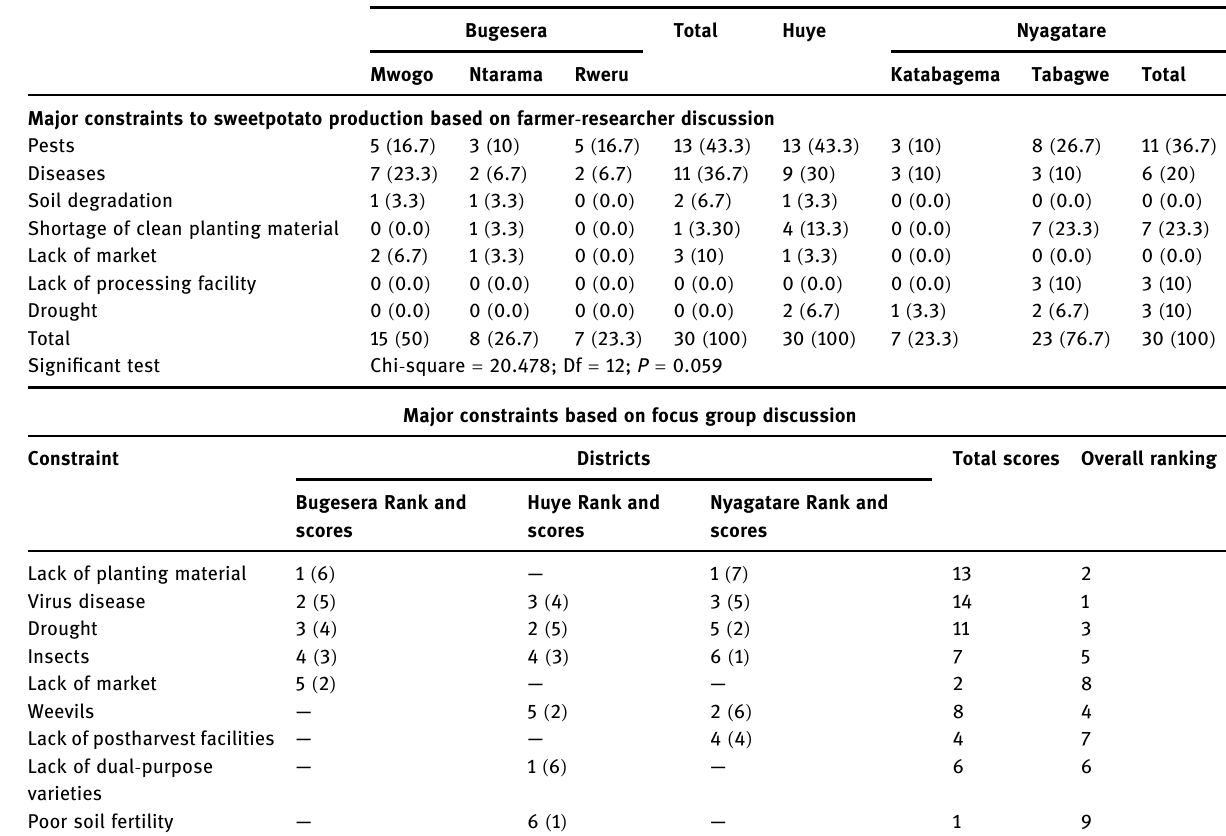
Table 5: Major constraints to sweetpotato production in three selected districts of Rwanda